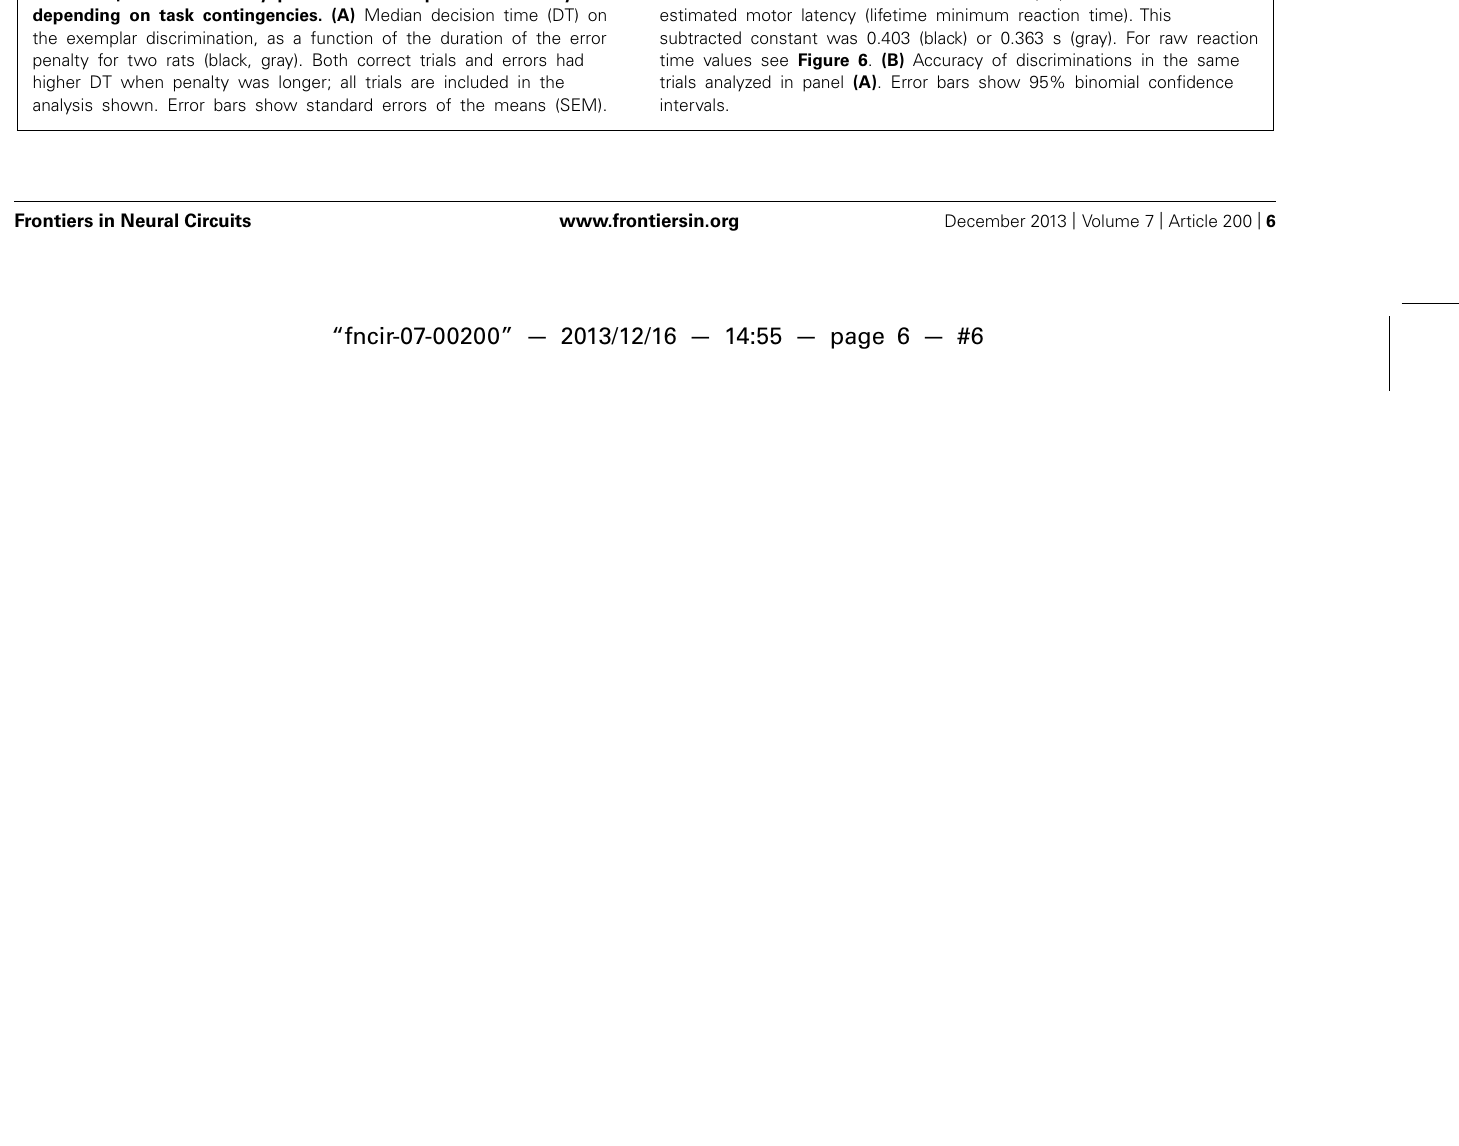
FIGURE 5 | Rats can flexibly prioritize either speed or accuracy depending on task contingencies. (A) Median decision time (DT) on the exemplar discrimination, as a function of the duration of the error penalty for two rats (black, gray). Both correct trials and errors had higher DT when penalty was longer; all trials are included in the analysis shown. Error bars show standard errors of the means (SEM).